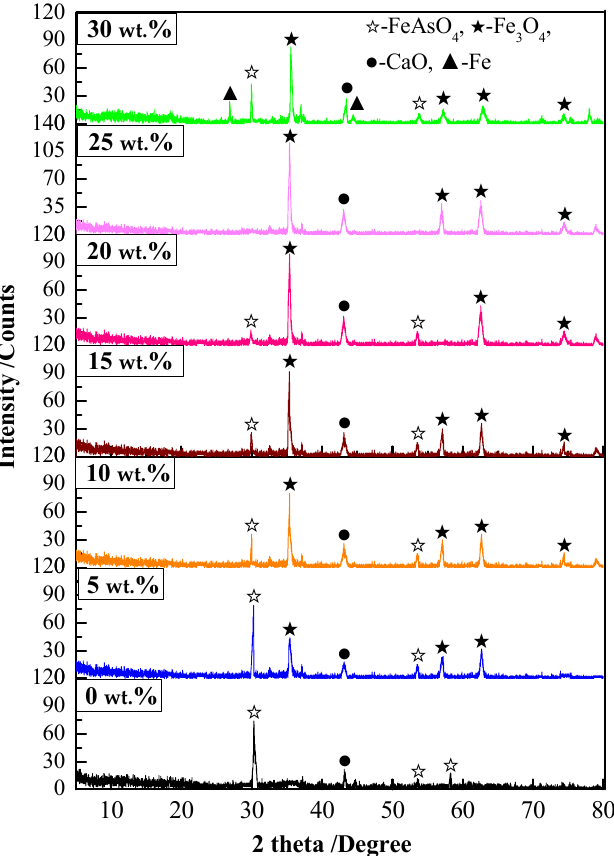
Figure 8. XRD patterns of the precipitate roasted under different coke powder additions.